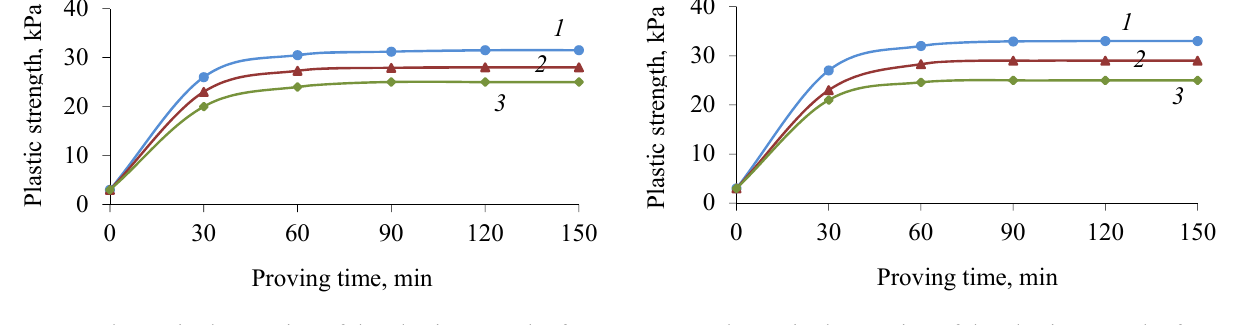
Fig. 4. Change in the proving of the plastic strength of jelly mass of the composition pectin and: ( 1 ) molasses + sugar + apple puree (control); ( 2 ) stevioside + apple puree; ( 3 ) stevioside + apple puree + juice from sea buckthorn berries + concentrated apple